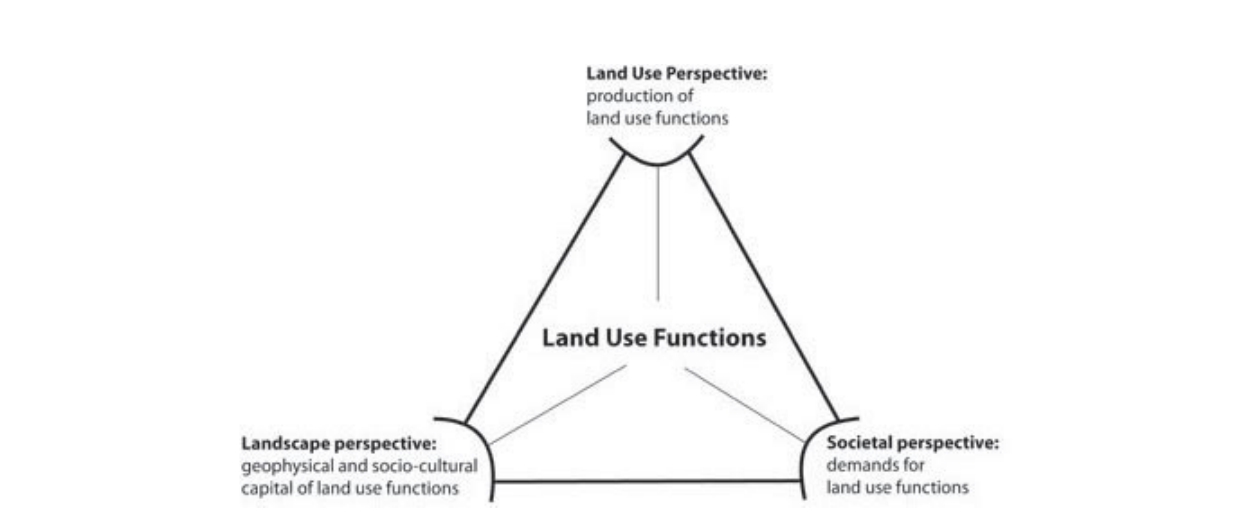
Fig. 3. Triangle of perspectives affecting the performance of Land Use Functions: capital, supply,